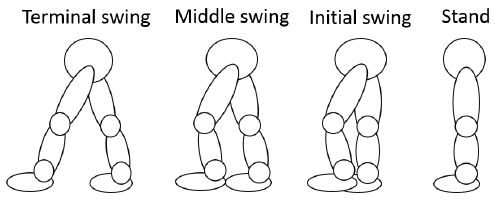
Figure 4. Parameters of the circle.